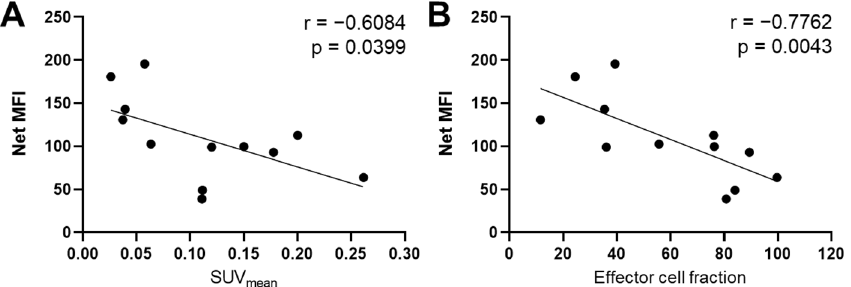
Figure 7. Tumor necrosis factor alpha (TNF- α ) expression is negatively correlated with mean stan- dard uptake value (SUV mean ) and effector cell fraction. TNF- α expression from day 12 E0771 tumors were correlated with ( A ) SUV mean and ( B ) effector cell fraction calculated from granzyme B-specific positron emission tomography imaging data on day six. Spearman’s rank-order correlation. Abbrevi- ations: Mean fluorescence intensity